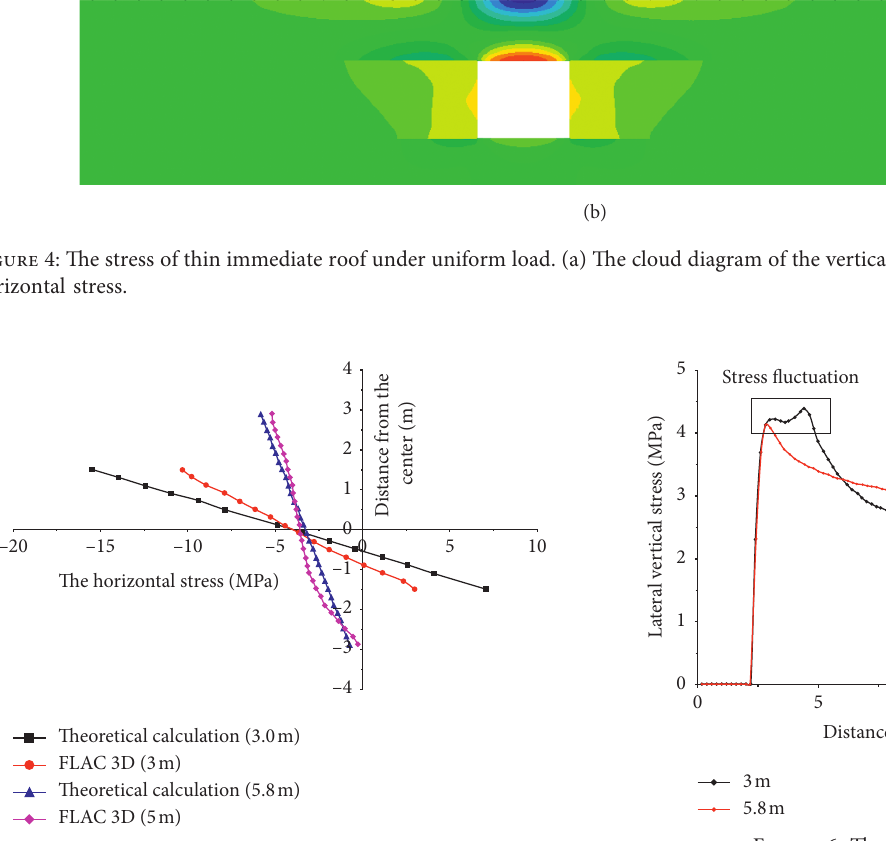
Figure 5: The horizontal stress at the center of thin immediate roof under uniform load.